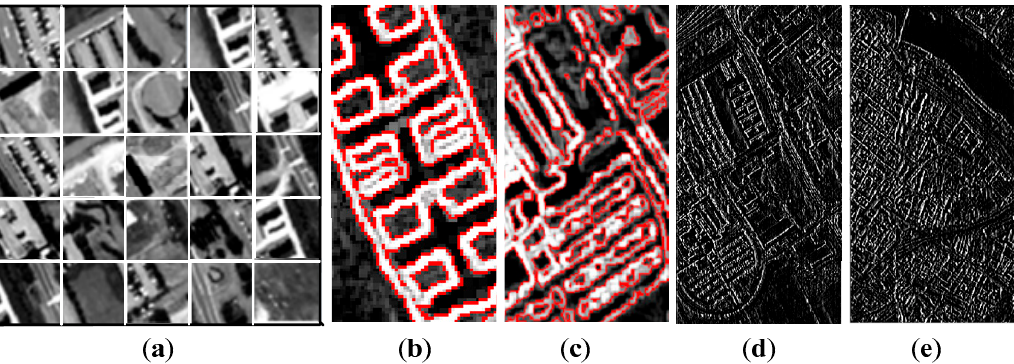
Figure 11. Edges detection via sparse regularization: ( a ) 5 × 5 pixels filter units; ( b ) sparse land cover edges; ( c ) dense land cover edges; ( d ) university scene; and ( e ) city center scene.